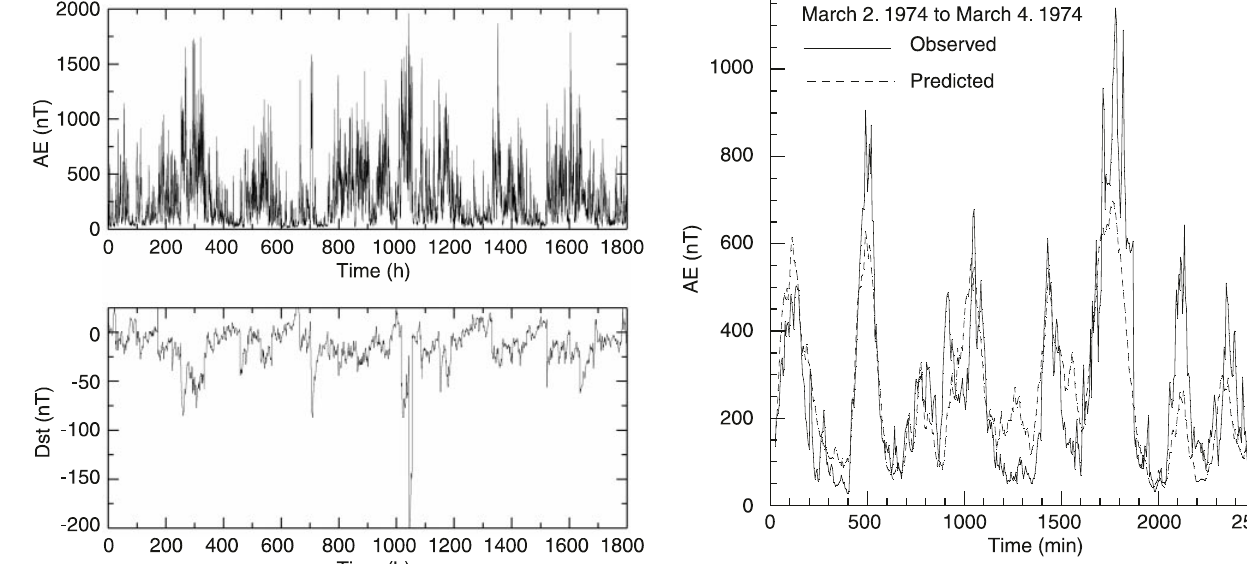
Fig. 2. Occurrences of AE and Dst during the period of study. The data consist of 40 intervals covering 1800 h selected from the period Nov. 1973 to Dec. 1974